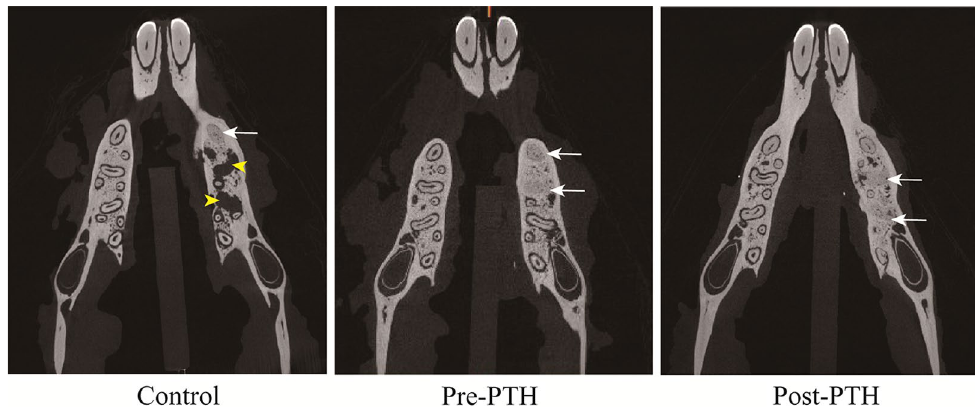
Figure 2. Representative images of micro-CT of each group. Insufficient bone healing was observed in control group (yellow arrowhead), whereas good bone healing of extraction socket was observed in pre-PTH and post- PTH groups (white arrow).